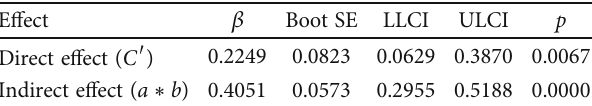
Table 4: Bootstrap test results of PE